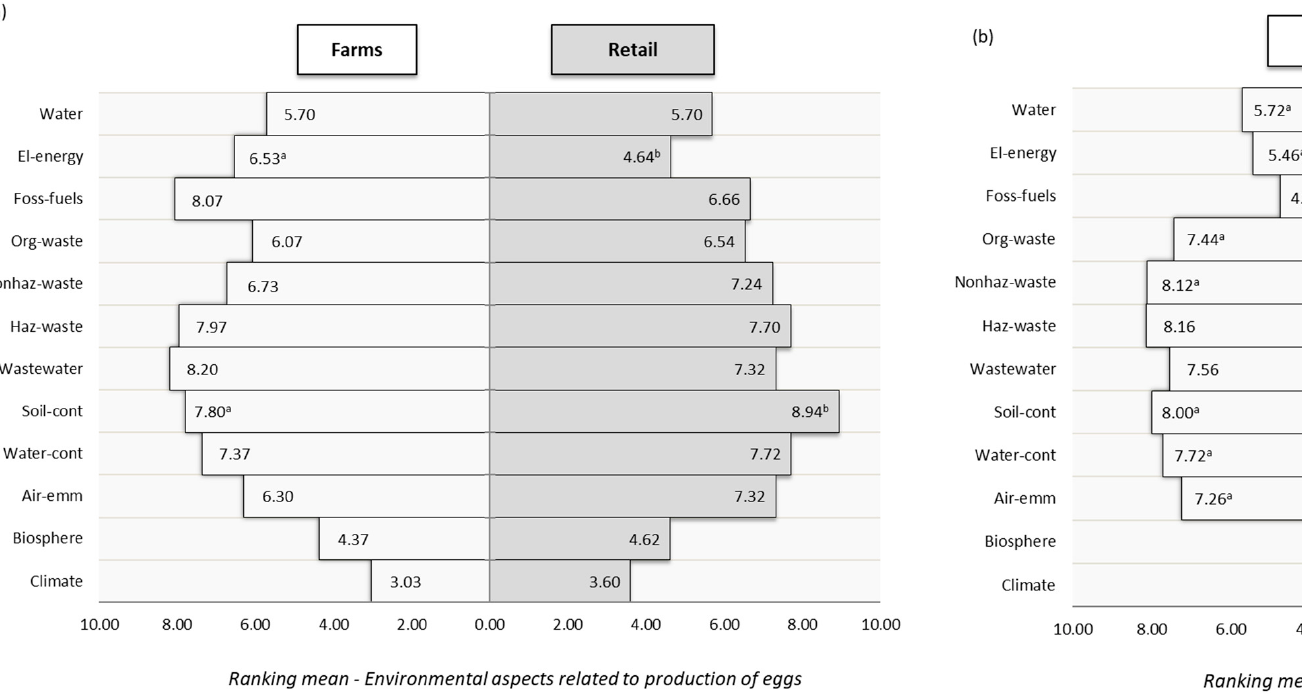
Figure 3. Environmental aspects related to the egg chain; ( a ) Interaction between farmers and retailers; ( b ) Interaction between retailers and households’ consumers. Note that different letters show statistically significant difference p < 0.05. Legend: El-energy—electric energy, Foss-fuel—fossil fuel, Org-waste—organic waste, Nonhaz-waste—nonhazardous waste, Haz-waste—hazardous waste, Soil-cont—soil contamination, Water-cont—water contamination, Air-emm—air emission.